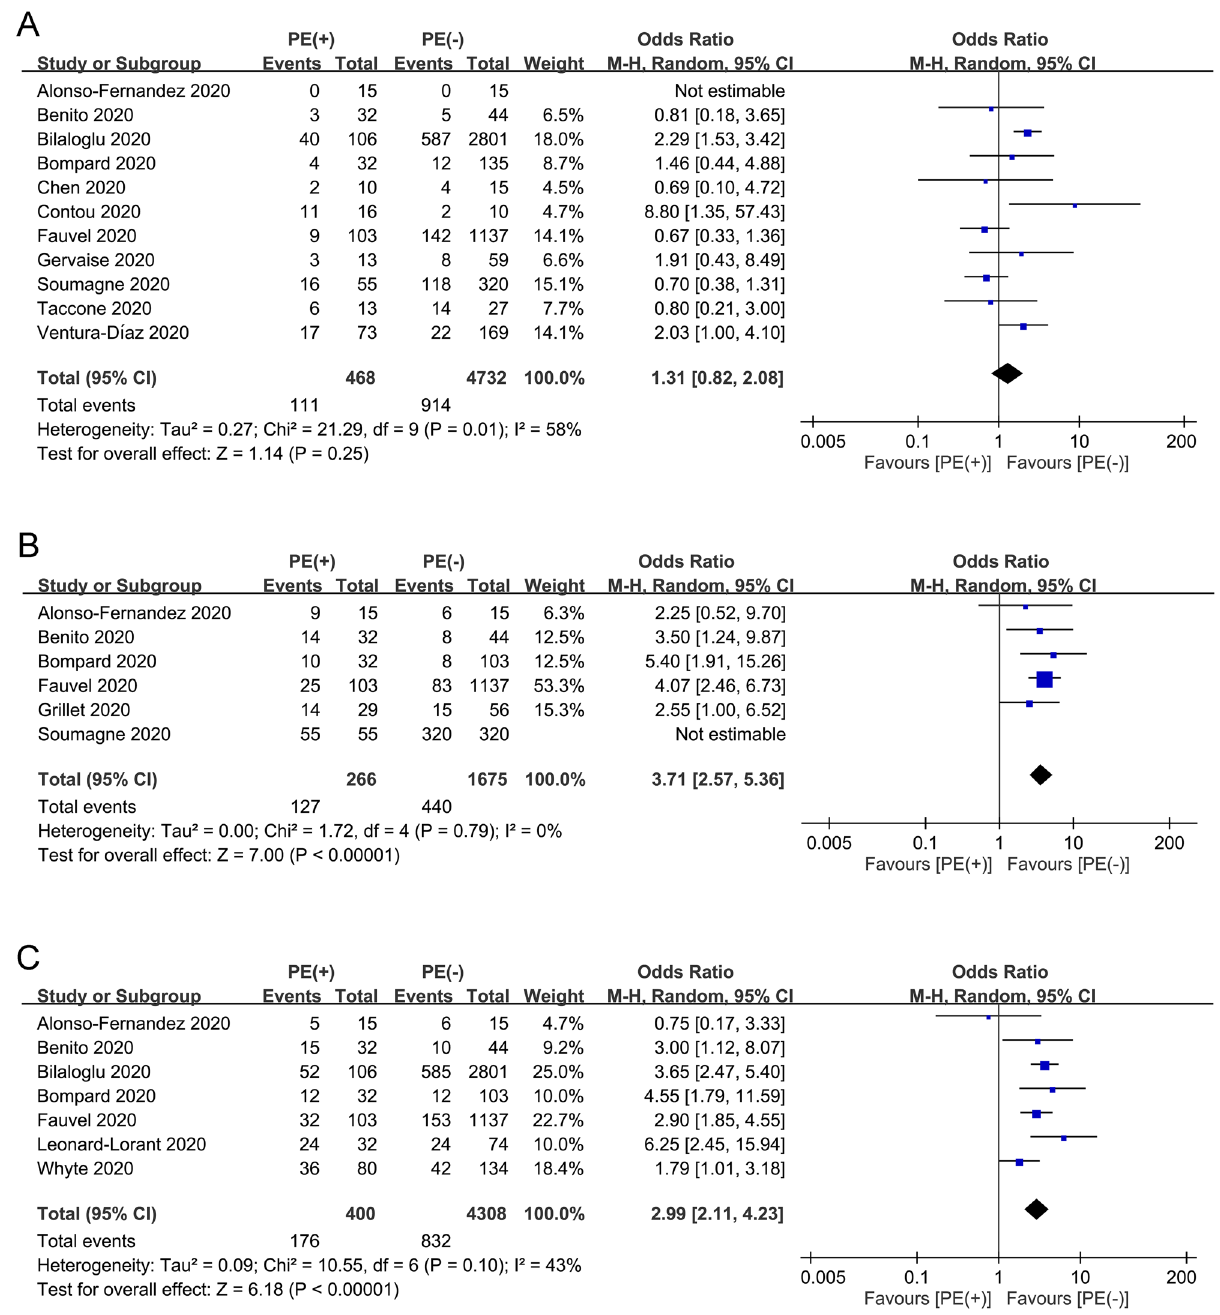
Figure 3. Forest plots for the comparison of risks for ( A ) mortality, ( B ) mechanical ventilation, and ( C ) intensive care unit admission between pulmonary embolism (PE) and non-PE groups. CI = confidence interval, M-H =